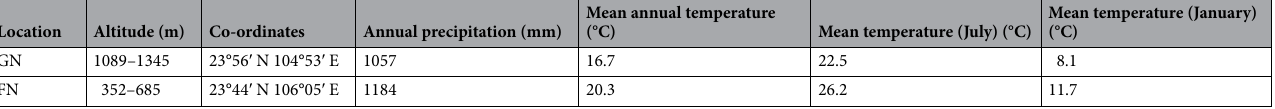
Table 1. Geographical description for the collection sites of Malania oleifera . GN Guangnan, FN